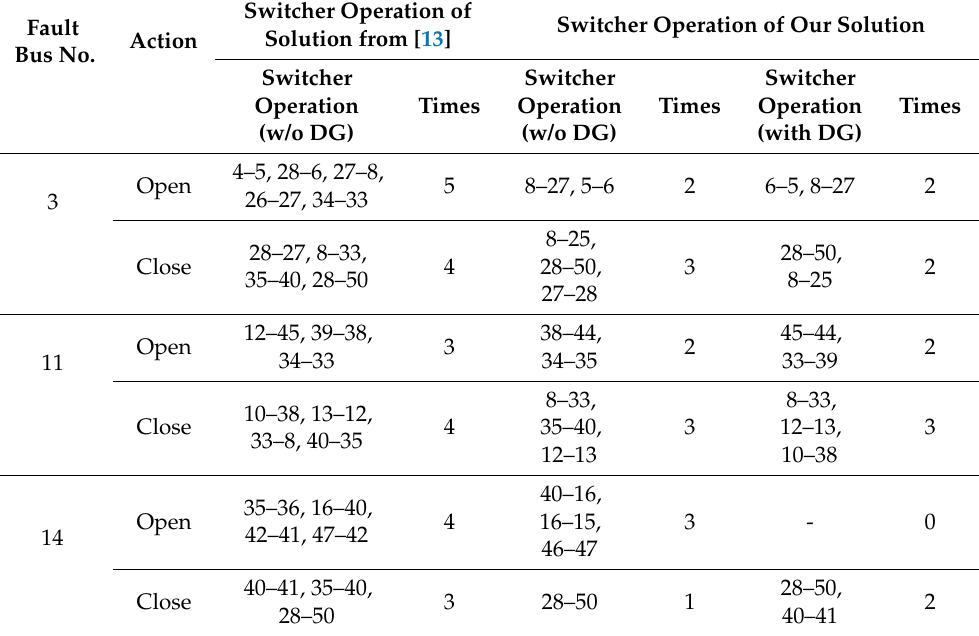
Table 1. Supply restoration paths and switcher operations.